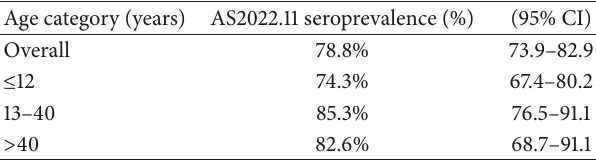
Figure 2: Scatter plot showing the relationship between anti- AS202.11 IgG concentrations (OD) and age of participants. Table 2: AS202.11 seroprevalence in each of the age